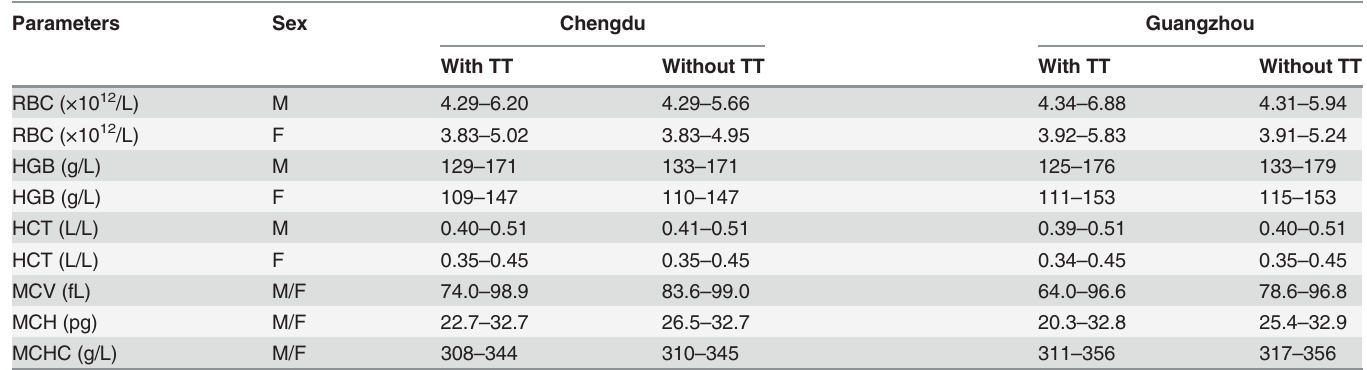
Table 2. Reference Intervals for RBC Pro fi les with and without TT Carriers. Parameters